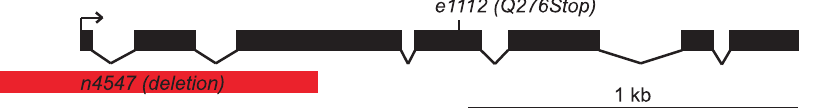
Figure 2. n4547 is a deletion allele of the tyrosine hydroxylase gene cat-2. n4547 contains a 1007 bp deletion that removes the first, second, and third exons of the cat-2 gene